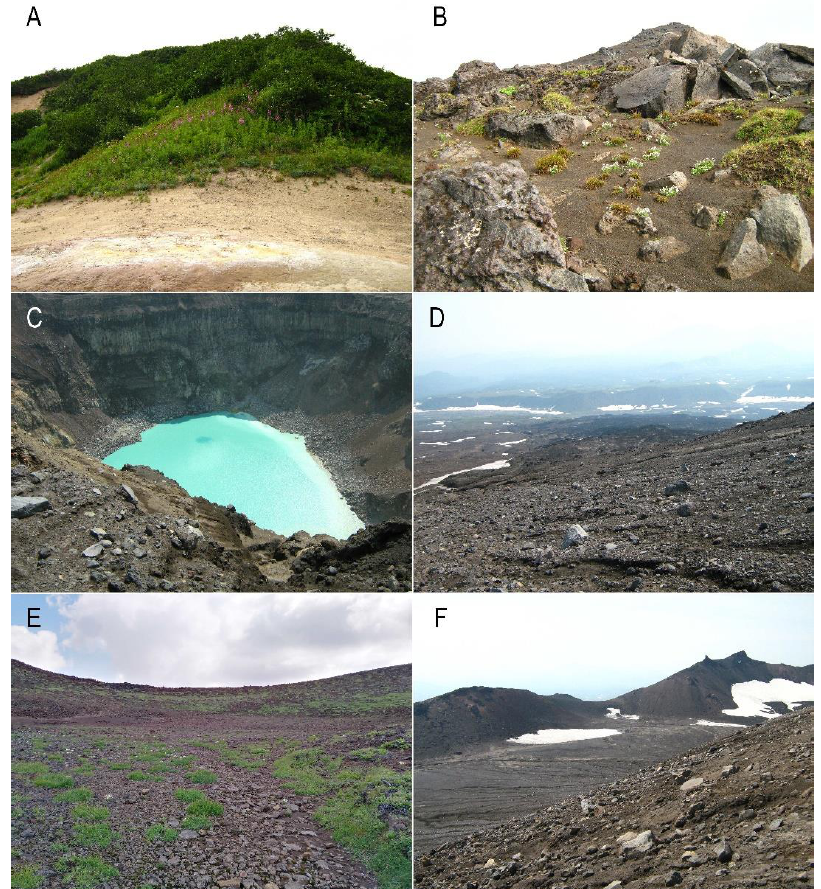
Figure 2. Study sites: ( A ) K2, alder forest at the base of the Mutnovsky volcano; ( B ) K5, flat area among sedges near the Gorely volcano; ( C ) K6, trail along the edge of the Gorely crater; ( D ) K10, down the east slope of the volcano; ( E ) K11, 1000 m from the top of the Gorely volcano; ( F ) K13, 800 m from the top of the volcano.